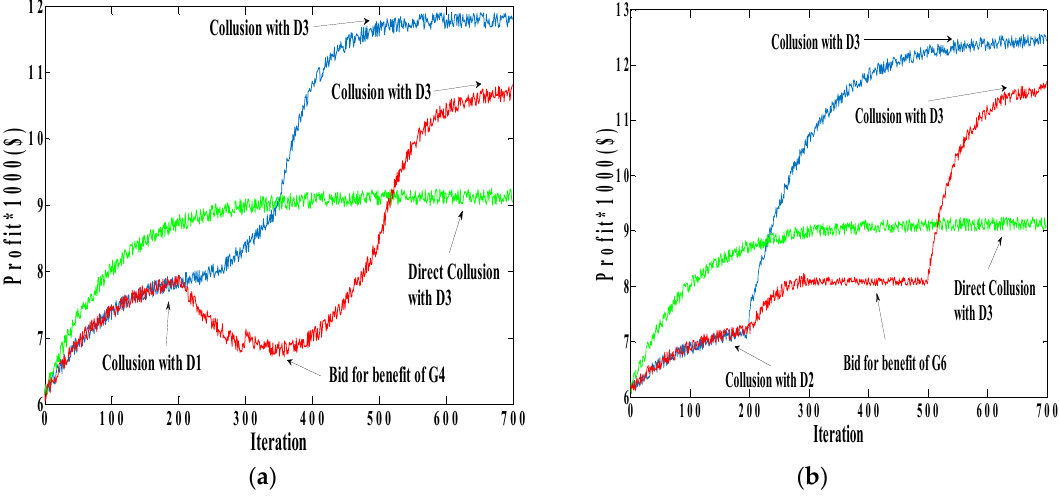
Figure 4. Profit functions of G1 as per ( a ) Case A; ( b ) Case B.